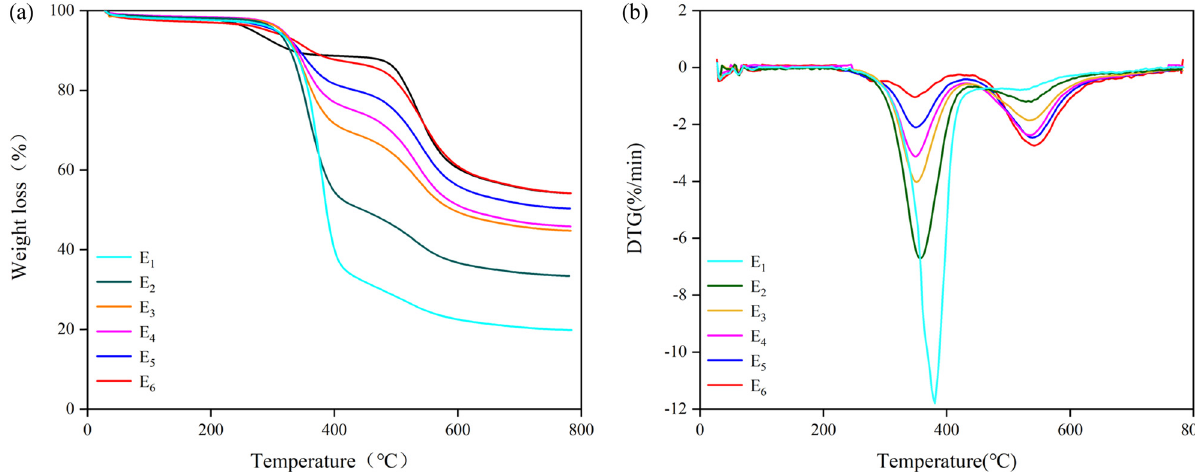
Figure 5: ( a ) TGA curves and ( b ) DTG curves of EP/PAA after curing.